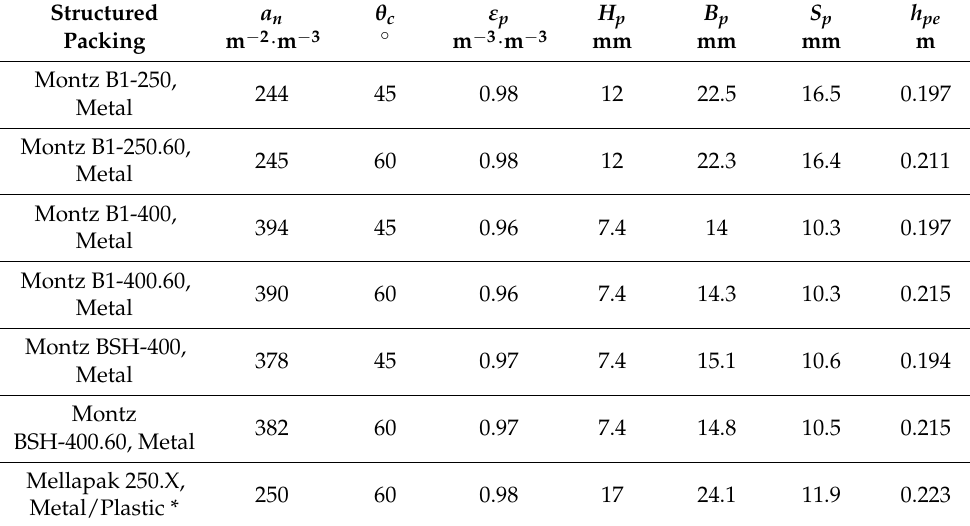
Table 6. Packing geometric parameters by Oluji´c et al. [74]. * The data for Mellapak 250.X are available in Flagiello et al.